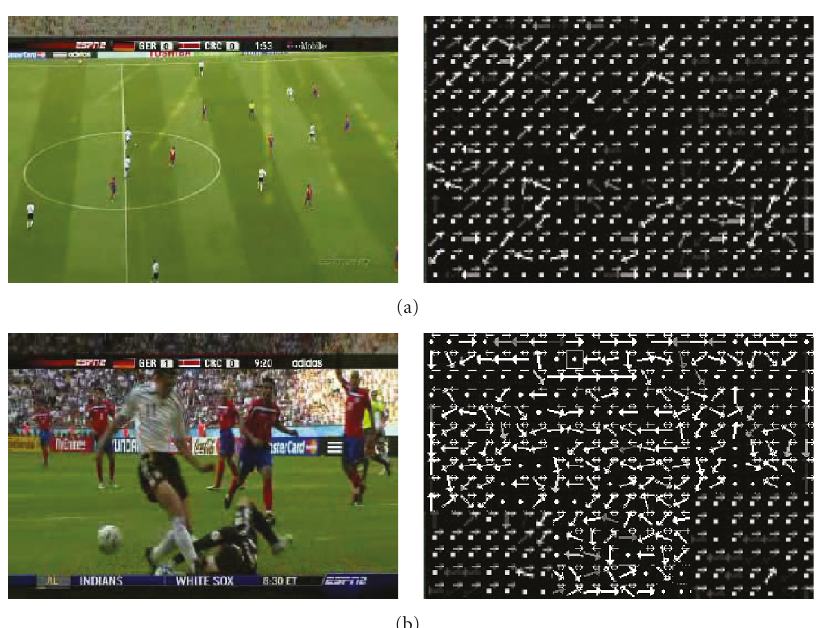
Figure 1: Motion vectors obtained from uncompressed domain by full-search motion estimation approach: (a) a nonsignificant event, (b) a significant